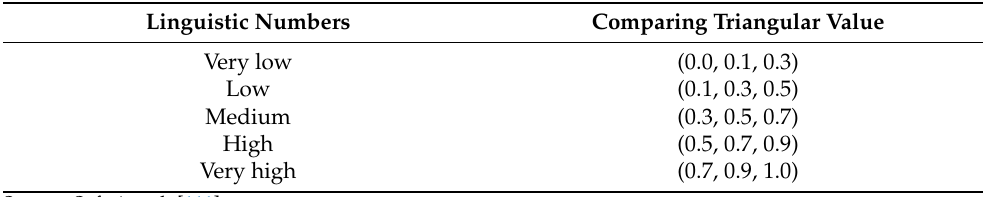
Table 2. Linguistic numbers for the significance of each measure. Linguistic Numbers Comparing Triangular Value Very low (0.0, 0.1, 0.3) Low Medium